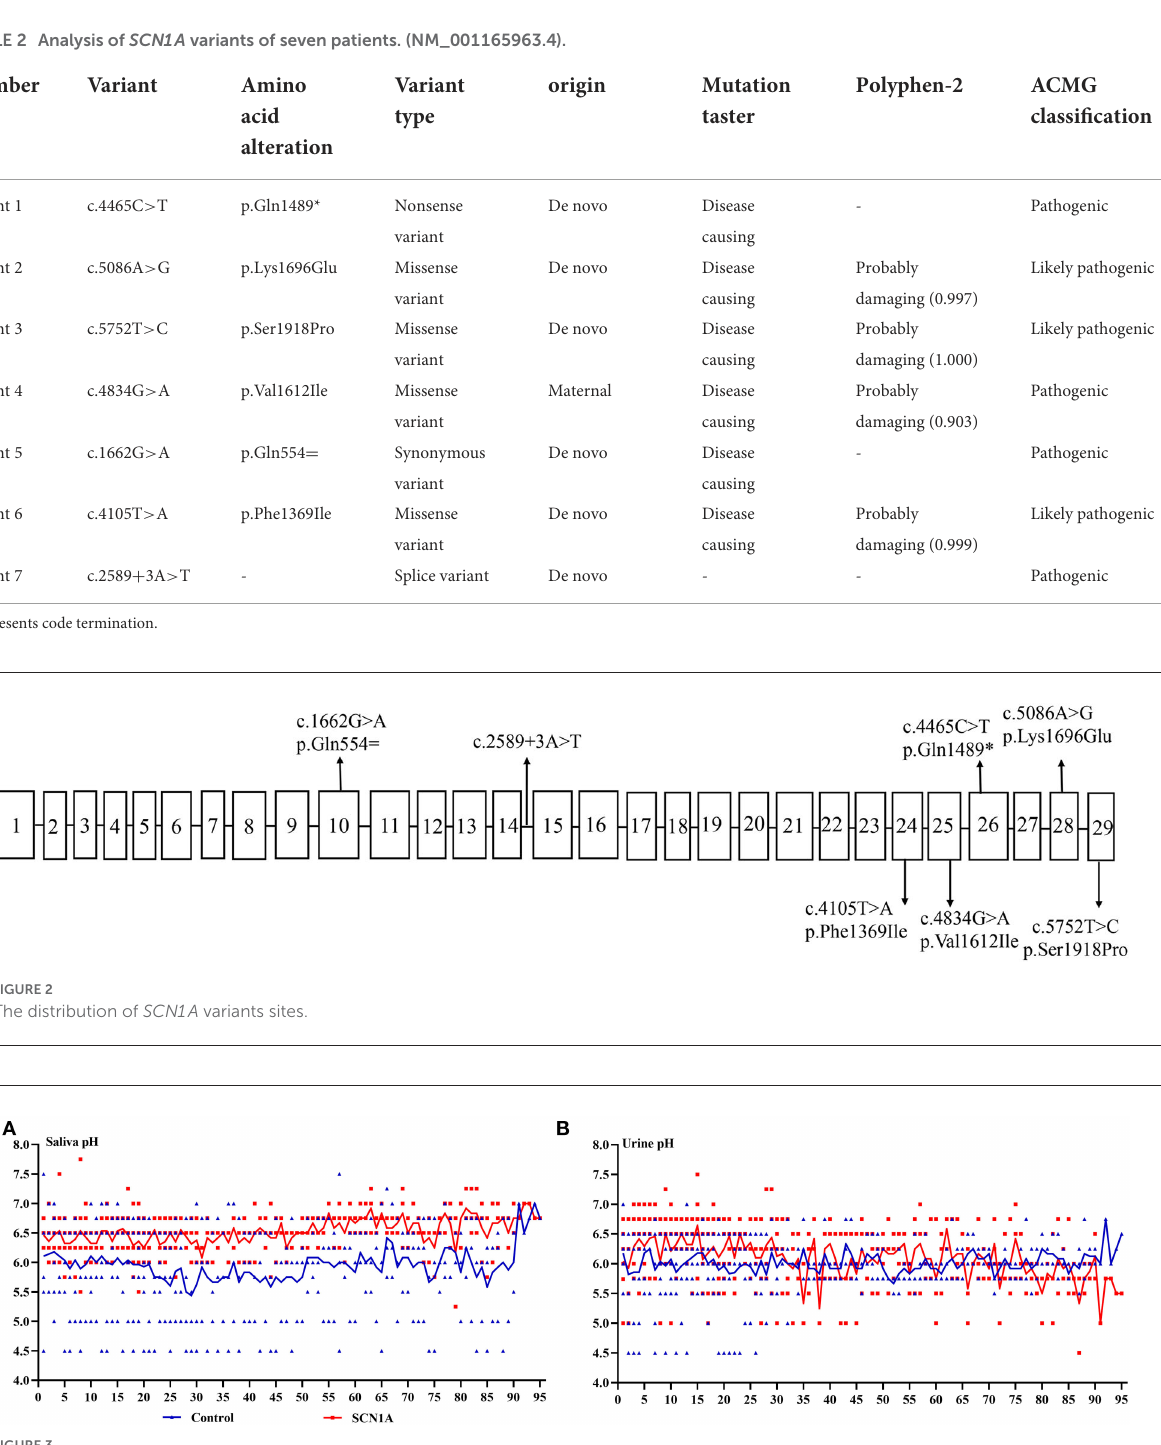
FIGURE3 The pH of fourteen participants. (A) Shows saliva pH. The saliva pH distribution of patients with SCN1A -related epilepsy was higher than that in the healthy group, and the average pH curve was higher than that in the healthy group. (B) Shows urine pH, which distribution of patients was higher than that in the healthy group. The horizontal axis is the number of monitoring days, the vertical axis is the pH, and the curve is the average pH. The blue triangle is the pH of the healthy group, and the red square is the pH of patients with SCN1A -related epilepsy.